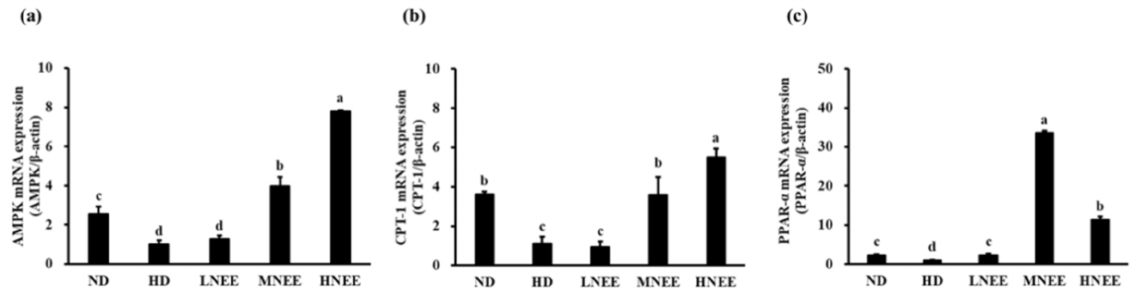
Figure 8. Effects of NEE on mRNA expression of the β -oxidation related gene in the liver of high calorie diet–induced obese rats. Quantitative real-time PCR was used to evaluate the gene expression of AMPK ( a ), CPT-1 ( b ), and PPAR- α ( c ). Duncan’s test was used to determine the significance of differences in mRNA expression of oxidation-associated genes. The data are the means and standard deviations ( n = 5). Different letters (a–d) denote statistically significant differences in mRNA expression ( p < 0.05). The group names are defined in Table 2